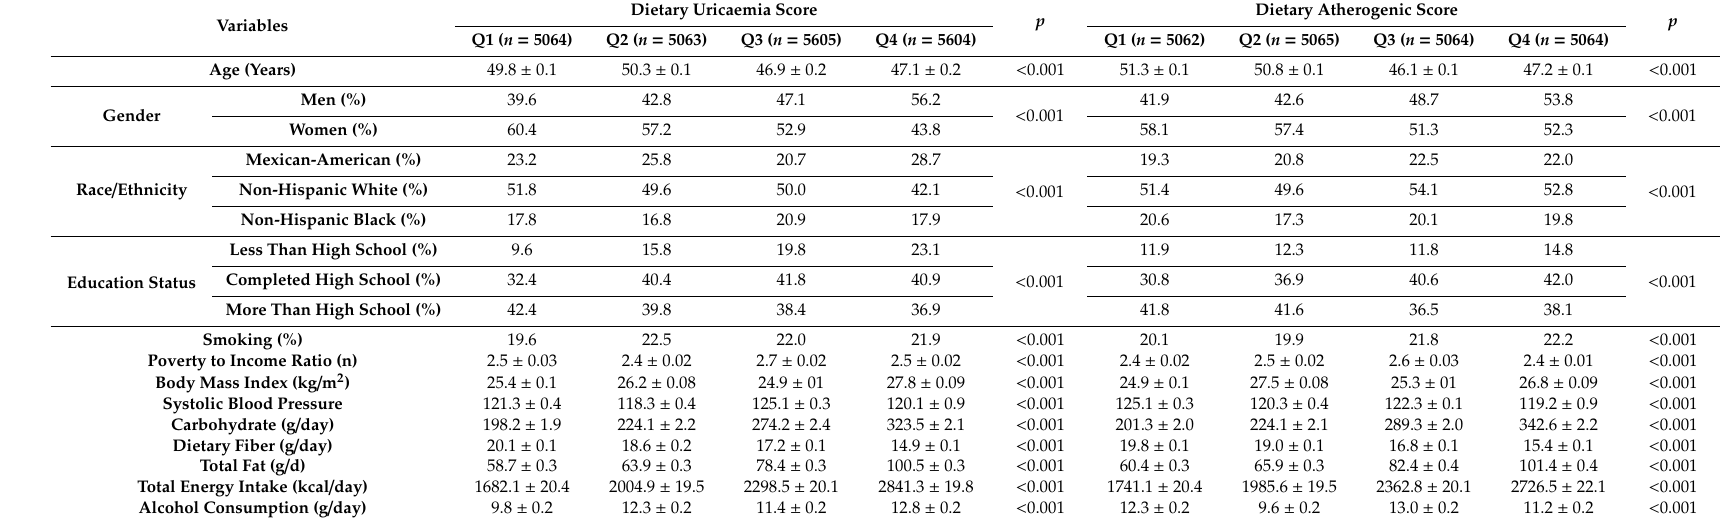
Table 1. Characteristics of the study participants based on the Dietary Uricaemia Score (DUS) and the Dietary Atherogenic Score (DAS) quartiles (Q). Variables